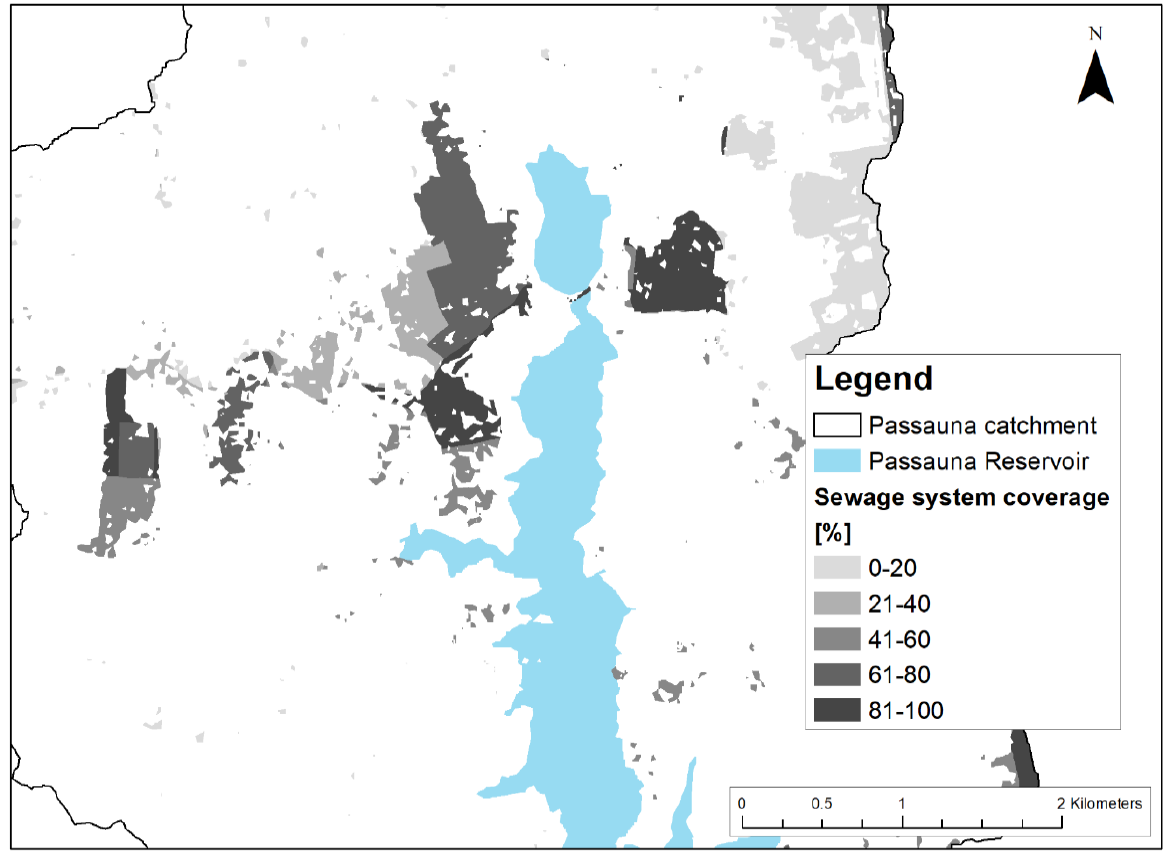
Figure 15. Sewage system coverage in the Ferraria region (adapted from [17]).